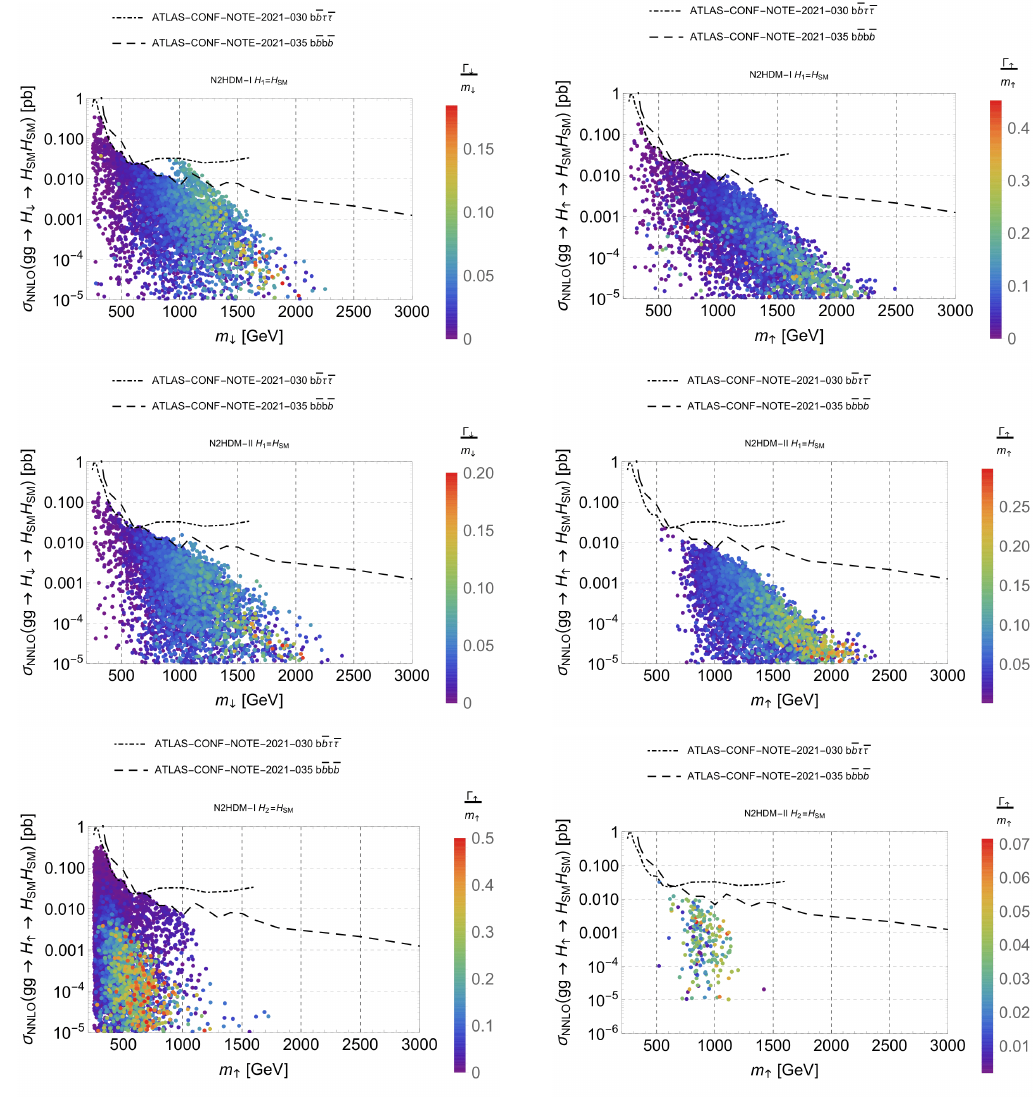
. Lower row: H in case of 1 ≡ H SM 2 ≡ H SM